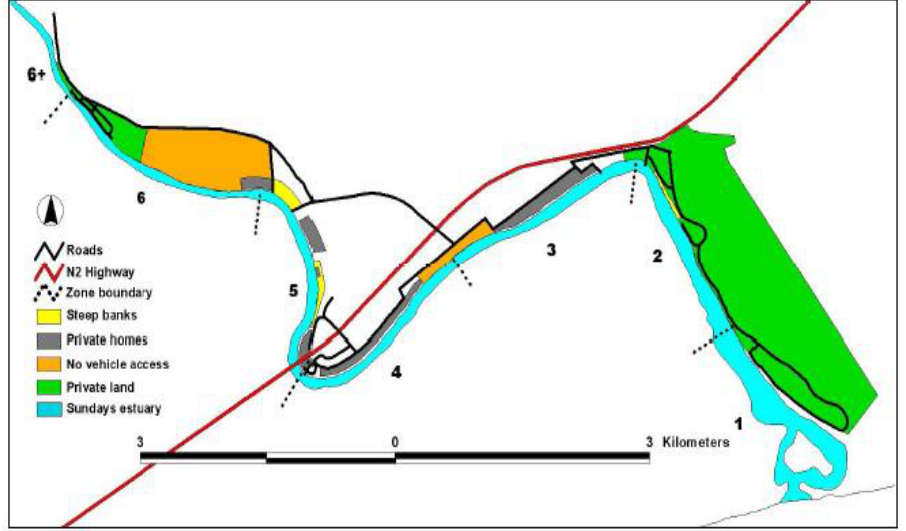
FIGURE 2: Spatial zones of the Sundays River Estuary Source: Cowley et al.